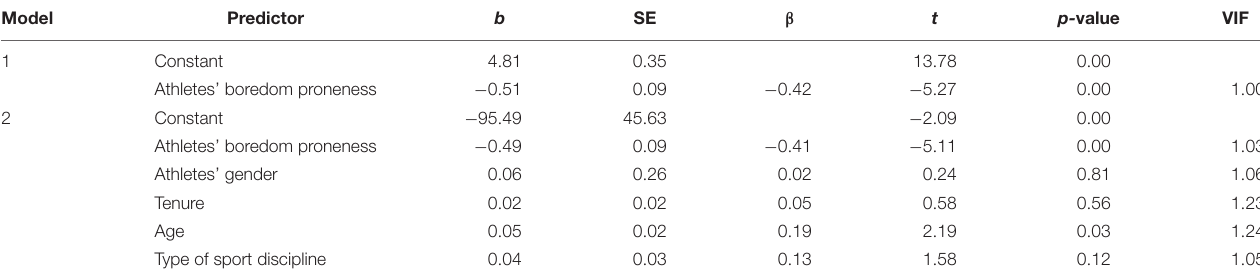
TABLE 3a | Athletes’ performance regression analysis. Model